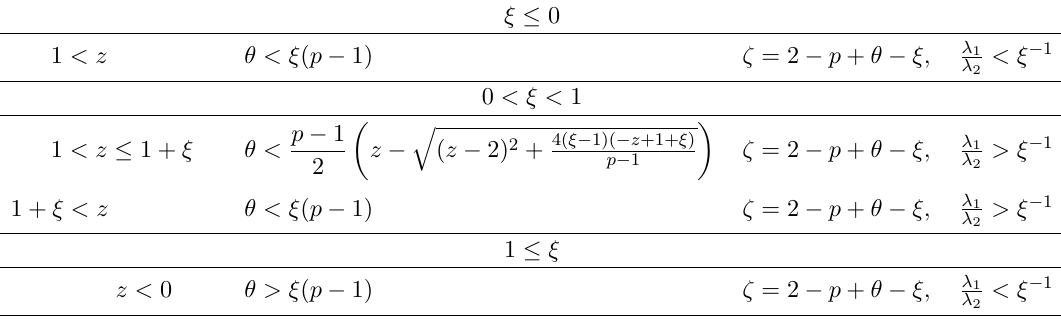
Table 8. Parameter range: Class I-ii, V 0 >